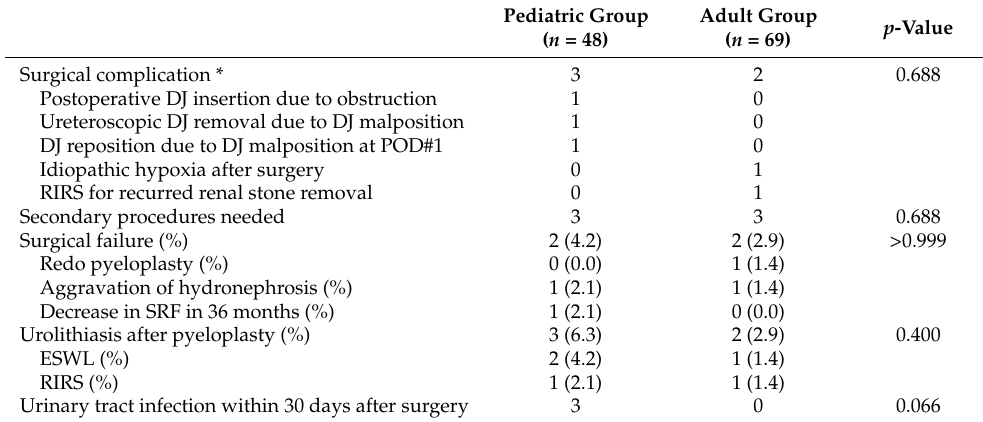
Table 3. Comparison of the surgical complication outcomes according to age.